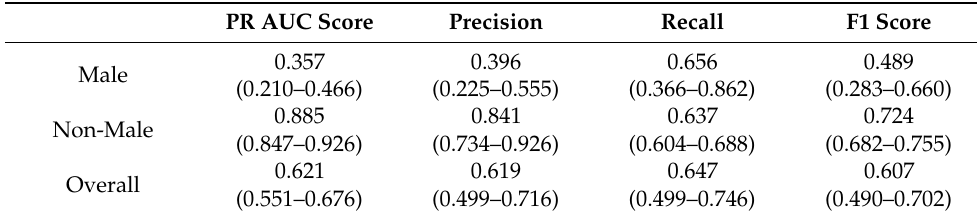
Table 5. Classification performance of normal and anomaly classes of complete test set.